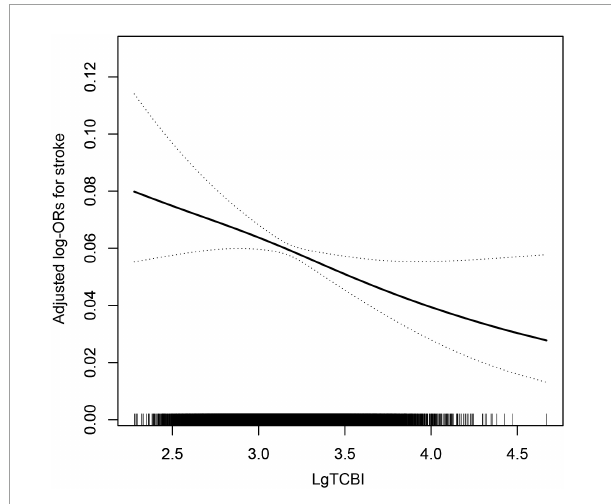
FIGURE1 The association between TCBI and the prevalence of stroke. The solid line and dashed line represent the estimated values and their corresponding 95% confidence interval, respectively. The adjustment factors included age, sex, BMI, SBP, DBP, current smoking, current drinking, diabetes, antihypertensive drugs, antidiabetes agents, antiplatelet drug, Hcy, FPG, HDL-C, LDL-C, SUA, and